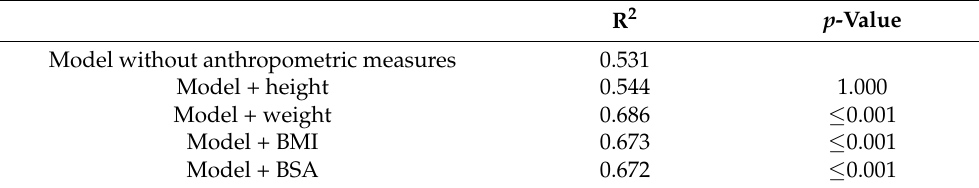
Table 5. Comparison of model fit with addition of different anthropometric variables. R 2 describes the proportion of the variance in DAP that can be explained by the multivariable model. R 2 p -Value Model without anthropometric measures 0.531 Model + height 0.544 1.000 Model + weight 0.686 ≤ 0.001 Model + BMI 0.673 ≤ 0.001 Model + BSA 0.672 ≤